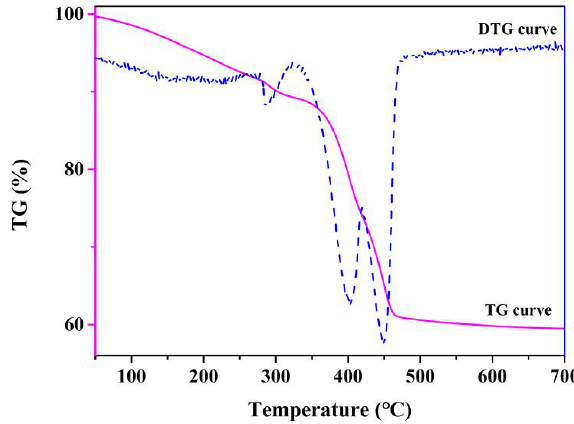
Figure 4. The TG and DTG curves of the TiO 2 precursor (HTiOF 3 ).